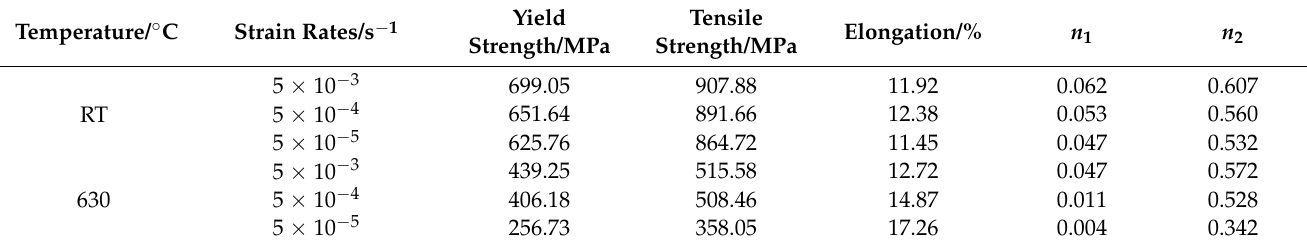
Table 3. Detailed tensile behavior under different strain rates at RT and 630 ◦